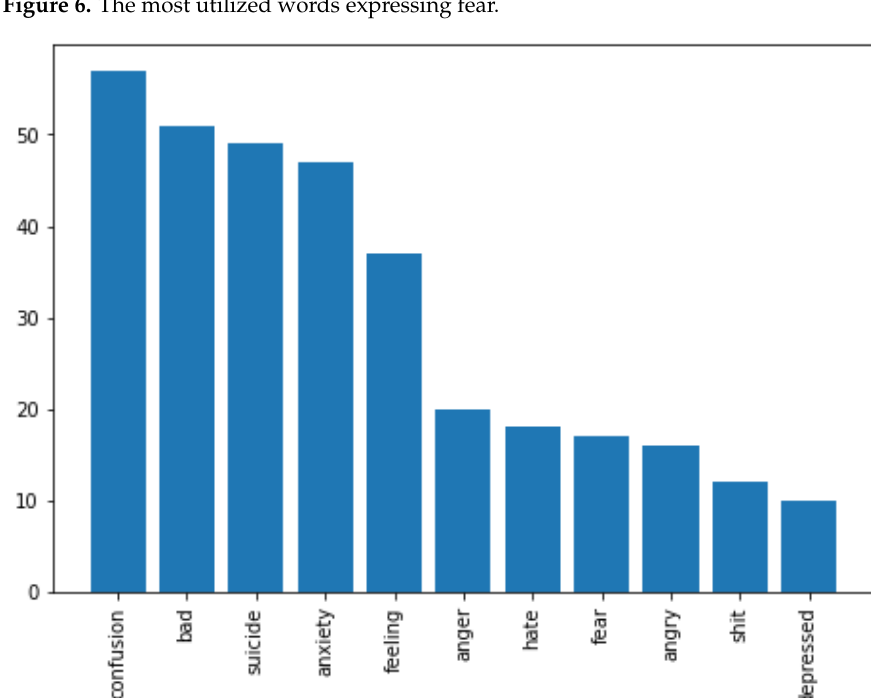
Figure 7. The most utilized words expressing